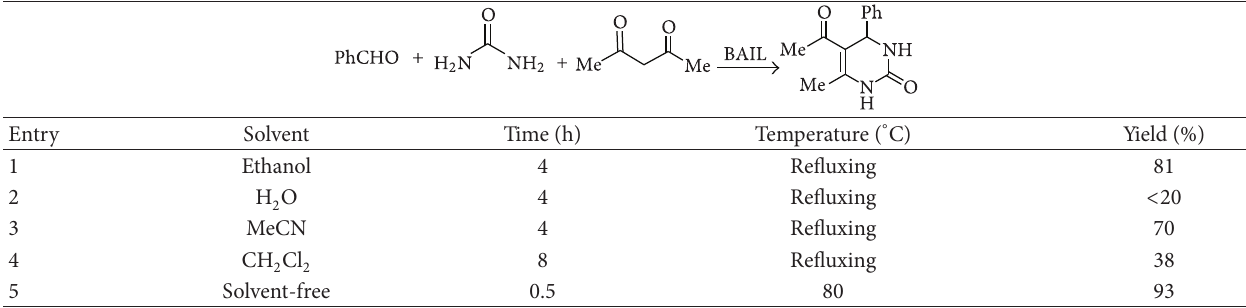
S 3: Mechanism of synthesis of 3,4-dihydropyrimidin-2(1H)-ones and -thiones. T 4: Formation of DHMP in different solvents and comparison with solvent-free